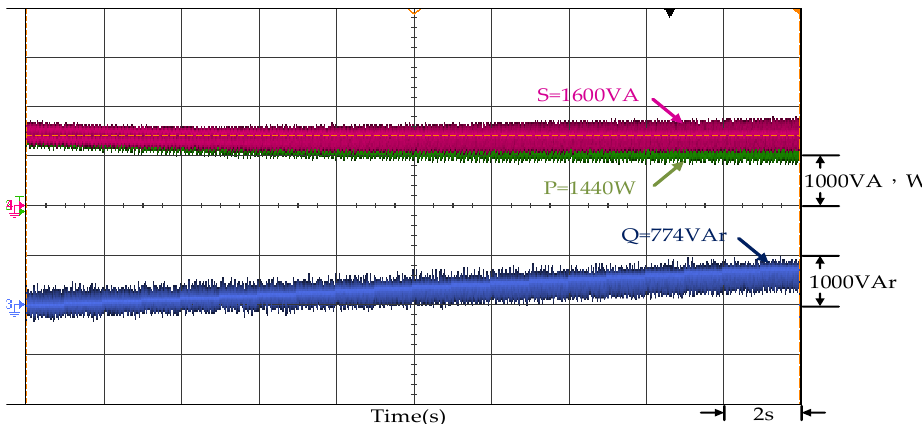
Figure 19. The output power regulation of the smart inverter when the per-unit value of mains voltage was between 1p.u. and 1.03p.u.